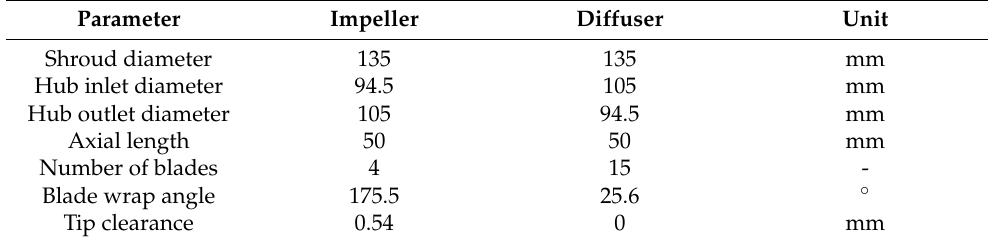
Table 1. Main parameters of HAMP.